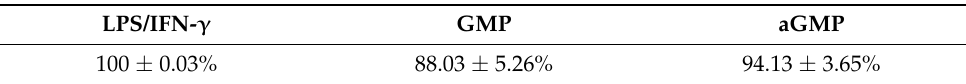
Table 2. Percentage of cell viability.